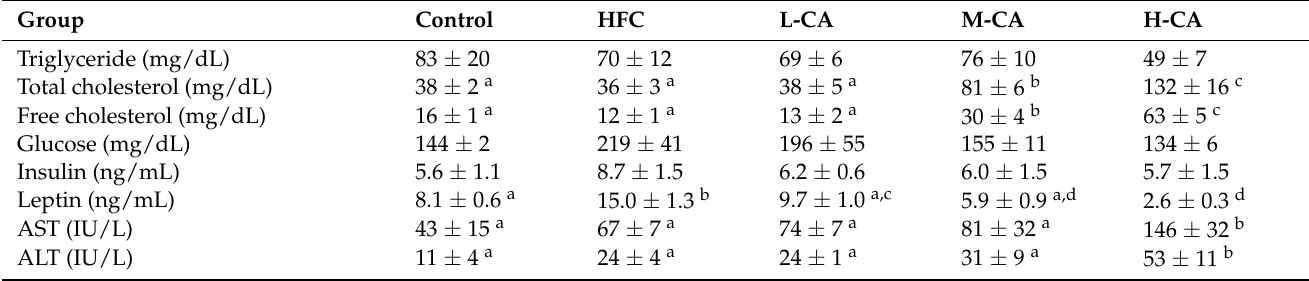
Table 3. Serum biochemical profile in Sprague–Dawley rats fed the normal, HFC, and CA- supplemented HFC diet for 9 weeks.